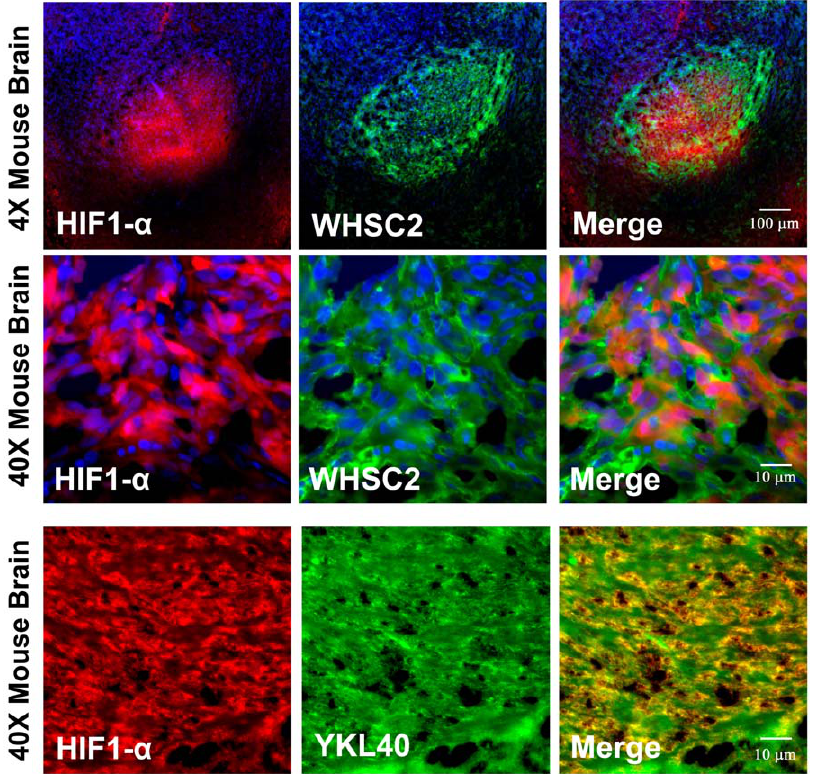
Figure 6. Two-color fluorescent microscopy shows co-localization of Whsc2 and YKL-40 with HIF-1 a in U251 CD133 + ‘‘stem-like’’ cell induced tumors. Human U251 neurosphere ‘‘stem cells’’ were implanted into the brain of a nude mouse. When the glioma was showing an effect on the mouse, the mouse was euthanized and the brain was removed. Serial sections were cut and then stained with either anti-HIF-1 a (red), Whsc2 (green) or YKL-40 (green). The nuclei are stained with DAPI (blue). The Top Panel Row shows a 4 6 magnification with HIF-1 a and Whsc2, while the Middle Row Panels are taken with a 40 6 magnification. The Bottom Row Panels are the 40 6 magnification of HIF-1 a and YKL-40 stained cells. and 6:1 effector: target ratios were used. We interpret this response to mean that more HLA-A2 molecules were loaded with the additional Whsc2 peptides, even though there were fewer HLA molecules on the hypoxic cells. So a higher percentage of HLA-A2 lower E:T.